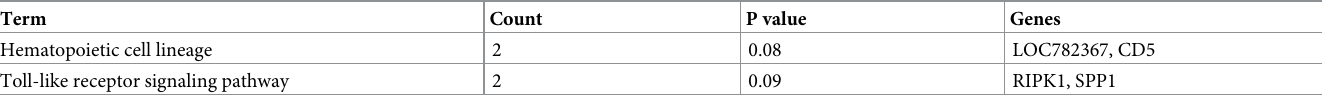
Table 3. DAVID pathways for main effect of intake.